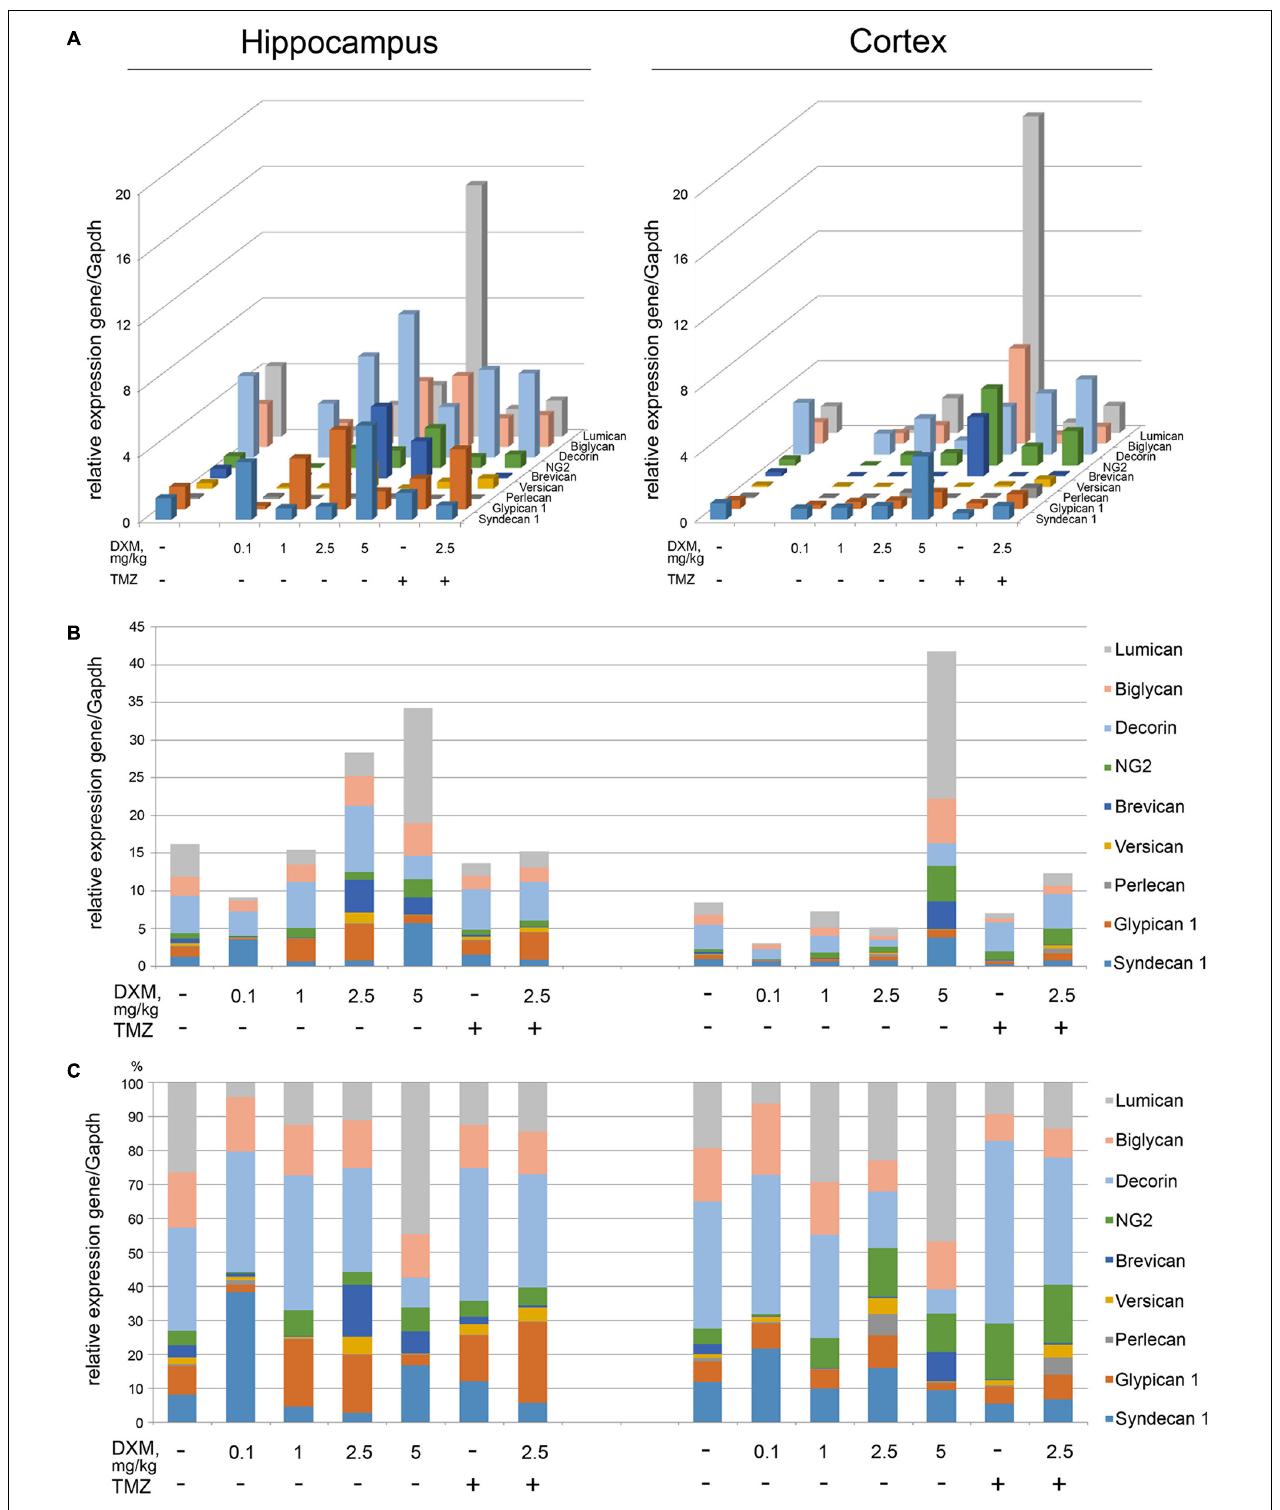
FIGURE 3 | Proteoglycan mRNA expression levels in hippocampus and cortex of 2-month Wistar rats before and after treatments with DXM and/or TMZ. (A) mRNA expression levels of individual proteoglycan genes. (B) Overall transcriptional activity of the total pool of the studied PGs. (C) Expression pattern of the individual PG core protein-coding gene as percentage of 100%. RT-PCR analysis, intensity of the amplified DNA fragments normalised to that of Gapdh . Bars represent the mean ± SD from triplicate experiments, Student’s t -test (OriginPro 8.0).